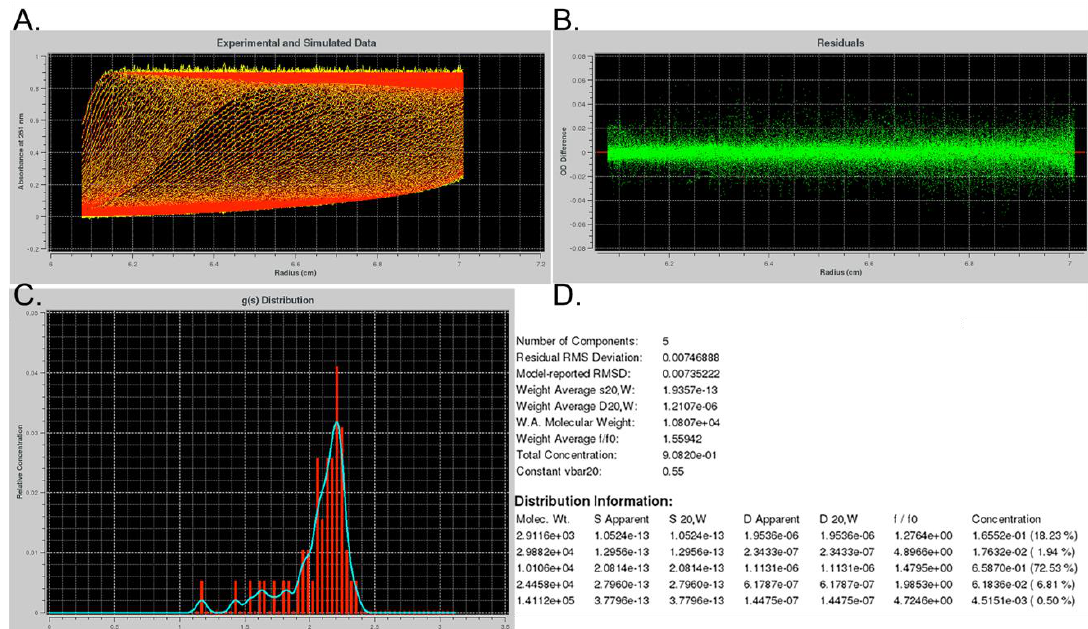
Figure 2. Analytical ultracentrifugation (AUC) of hex4 _A5U annealed in KCl shows formation of a compact structure. ( A ) Raw sedimentation scans (yellow) overlaid with the calculated fit (red). ( B ) Residuals between the fit and the model plot showing their random nature. ( C ) Relative concentration and distribution of the species with different sedimentation coefficients. ( D ) Summary table of the contents of the solution after genetic algorithm analysis as implemented in Ultrascan 3 [47,48].